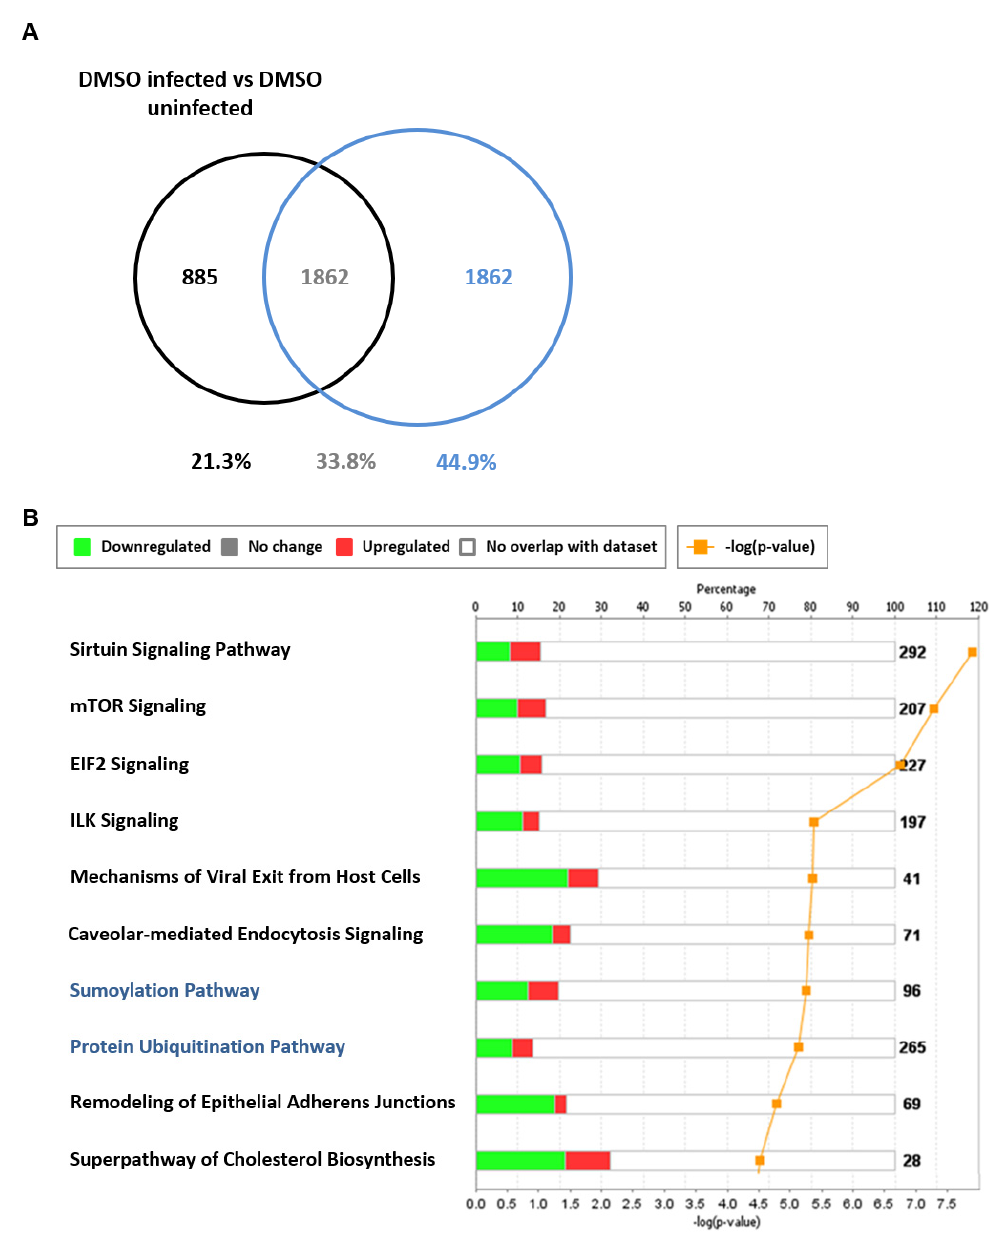
Figure 9. Di ff erentially expressed genes exclusive to TG-primed and infected NHBE cells. NHBE cells were primed with 0.01 µ M TG for 30 min, washed with PBS and infected with USSR H1N1 virus at 0.8 MOI for 12 h for RNA-seq followed by IPA analysis. ( A ) Di ff erentially expressed genes (1862 transcripts) in NHBE cells in response to infection (based on filtering parameters of q < 0.05 and log2-fold-change < − 1 and > + 1) were identified as exclusive to TG-primed and infected NHBE cells (i.e., [TG-primed infected / TG-primed uninfected] less (DMSO infected / DMSO uninfected)). ( B ) Protein sumoylation and ubiquitination (highlighted blue) were among the enriched canonical pathways represented in the 1862 transcripts (based on filtering parameters of q < 0.05 and log2-fold-change < − 1 and > + 1) exclusive to TG-primed and infected NHBE cells. The stacked bar chart displays the percentage of significant di ff erentially expressed genes that are upregulated (red) or downregulated (green) in each canonical pathway. The number of genes within the pathway recognised by IPA indicated by the numbers to the right of the bars. Orange line represents the − log p -value, indicating the statistical significance of the over-represented canonical pathway.